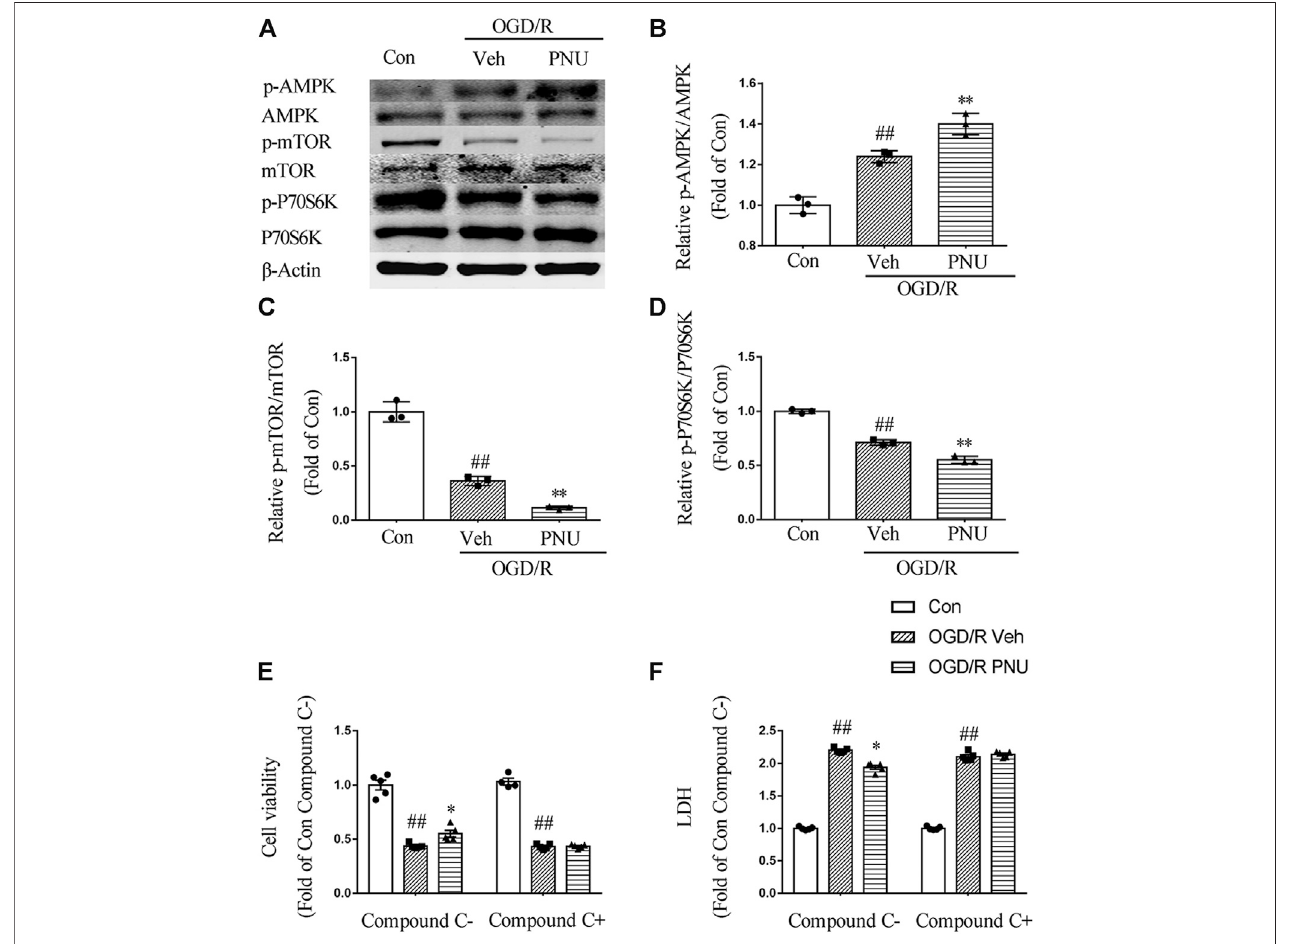
FIGURE 5 | AMPK-mTOR pathway is involved in the neuroprotection of α 7nAChR activation. Primary cortical neurons were treated with or without PNU282987 100 μ M for 2 h before OGD/R exposure. (A – D) The expression and phosphorylation of AMPK, mTOR, and P70S6K were detected by Western blot. OGD/R exposure increasedthelevelofp-AMPKanddecreasedthelevelsofp-mTORandp-P70S6K.PNU282987treatmentfurtherenhancedthelevelofp-AMPKandreducedthelevels of p-mTOR and p-P70S6K. n (cid:2) 3 for each group. (E, F) In addition, compound C (5 μ M), an AMPK inhibitor, signi fi cantly inhibited the effects of PNU282987 treatment on cell viability and LDH release. n (cid:2) 5 for each group. ## p < 0.01 vs. con; * p < 0.05 vs. OGD/R veh; and ** p < 0.01 vs . OGD/R